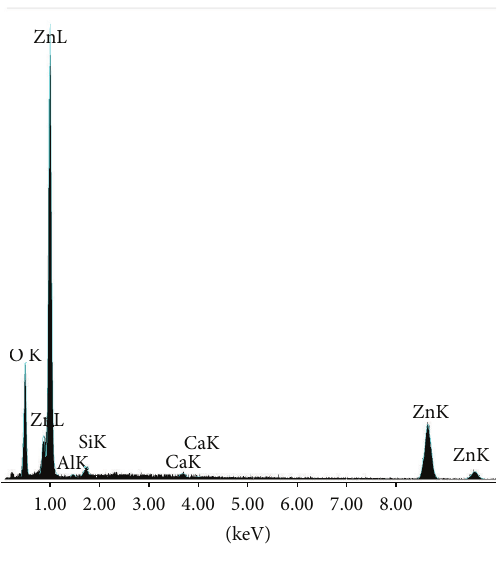
Figure 4: EDX pattern of AZO film.